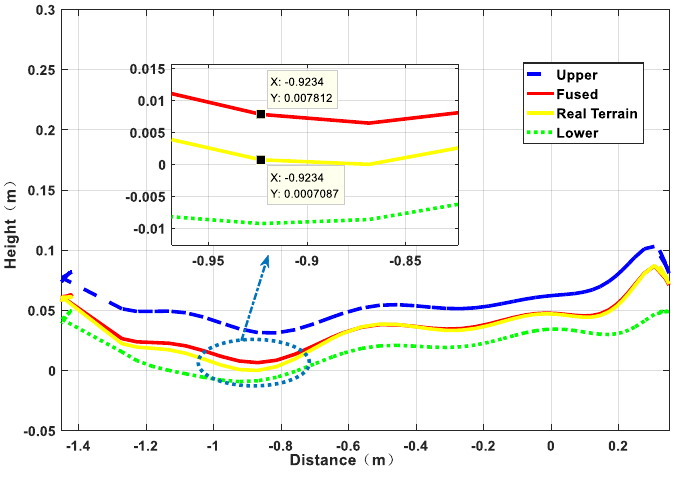
Sensors 2019 , 19 , x